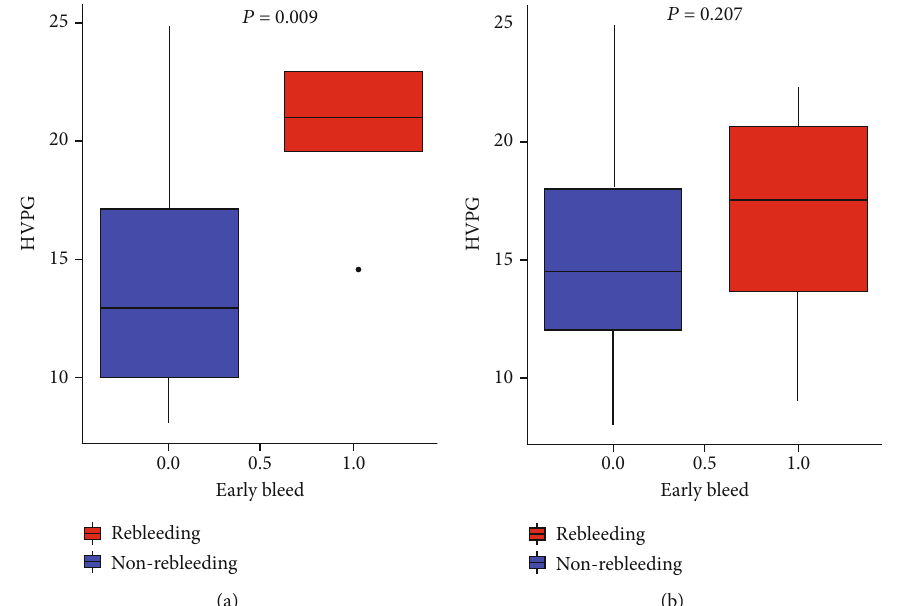
Figure 1: Comparisons of HVPG in patients with and without early rebleeding in (a) the nonascites cohort and (b) the ascites cohort. HVPG: hepatic venous pressure